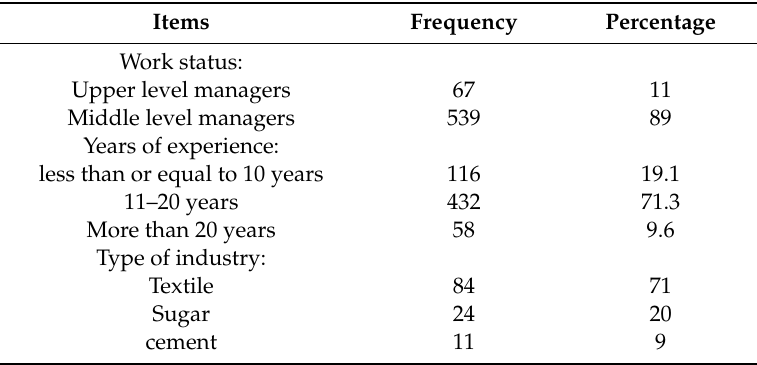
Table 1. Respondents’